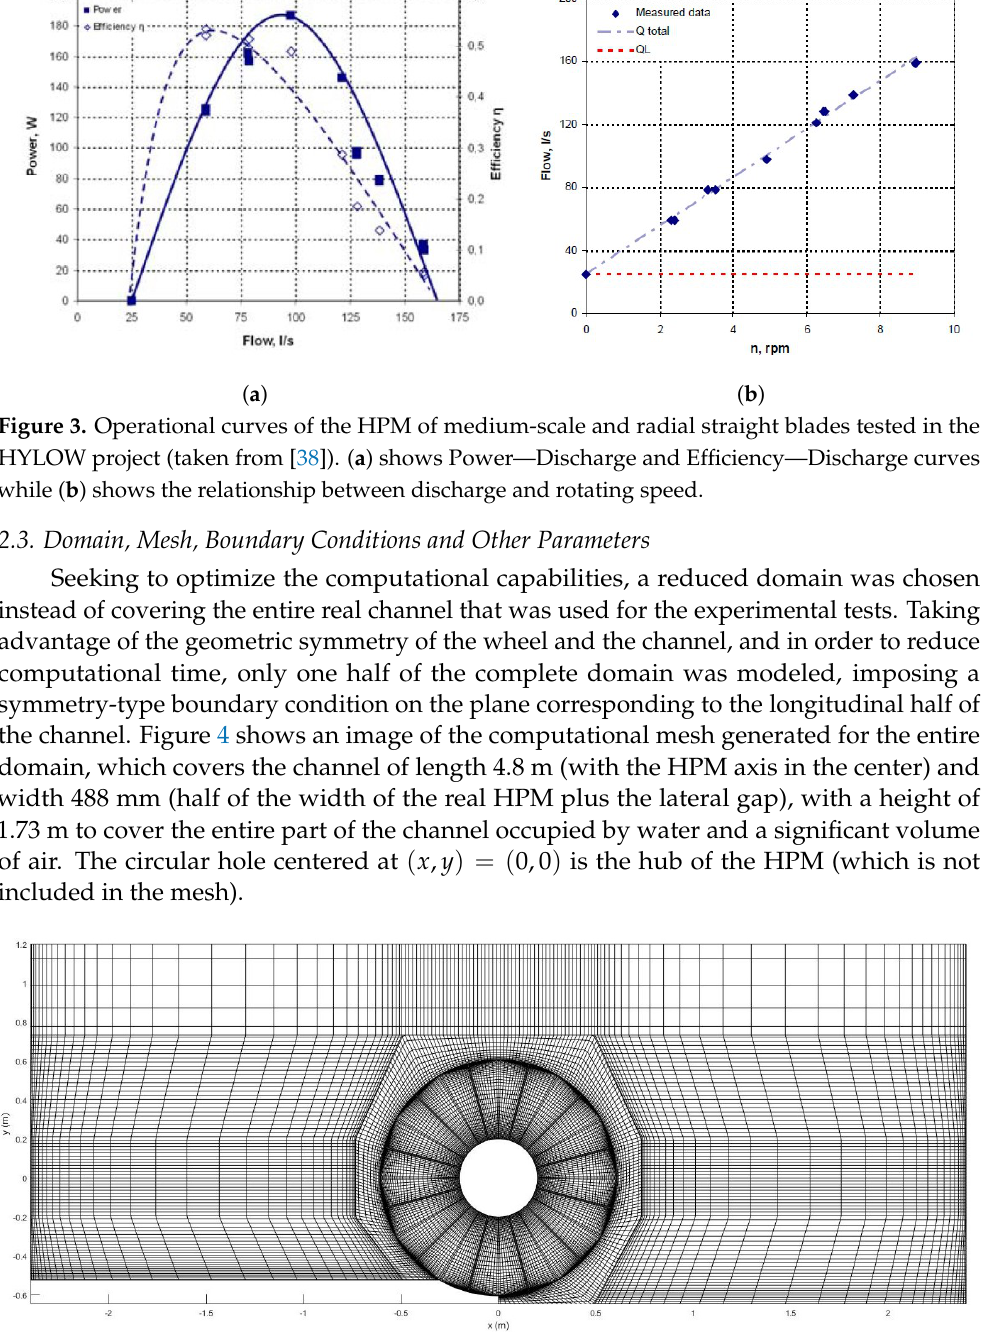
Figure 4. Complete computational mesh for the simulation of the HPM in caffa3d